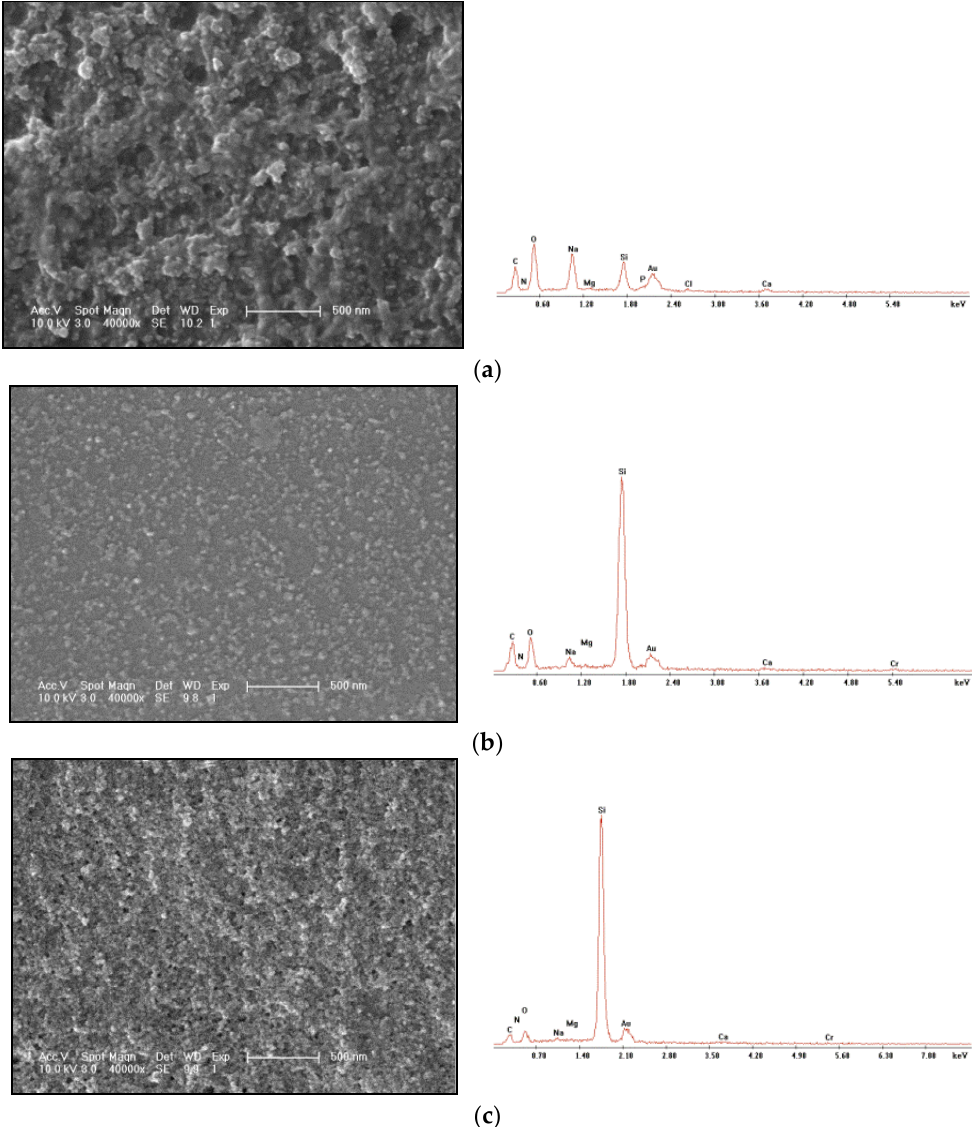
Figure 6. Changes at different times during gel formation. ( a ) Gel freeze-drying SEM photos and EDS energy spectrum of the original sample. ( b ) SEM photos and EDS energy spectrum of 0.150–0.250 mm gel freeze-drying. ( c ) SEM photos and EDS spectra of 0.250–0.420 mm gel freeze-drying.